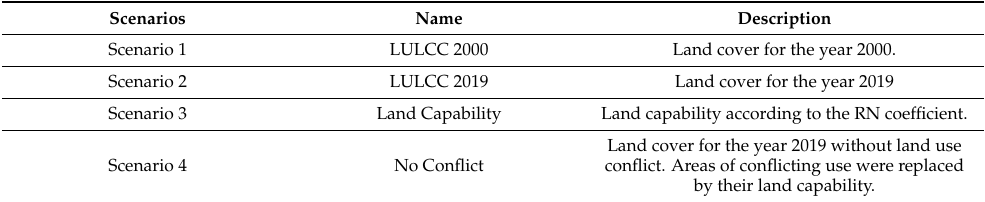
Table 3. Scenario of LULCC in the Paraopeba River Basin.